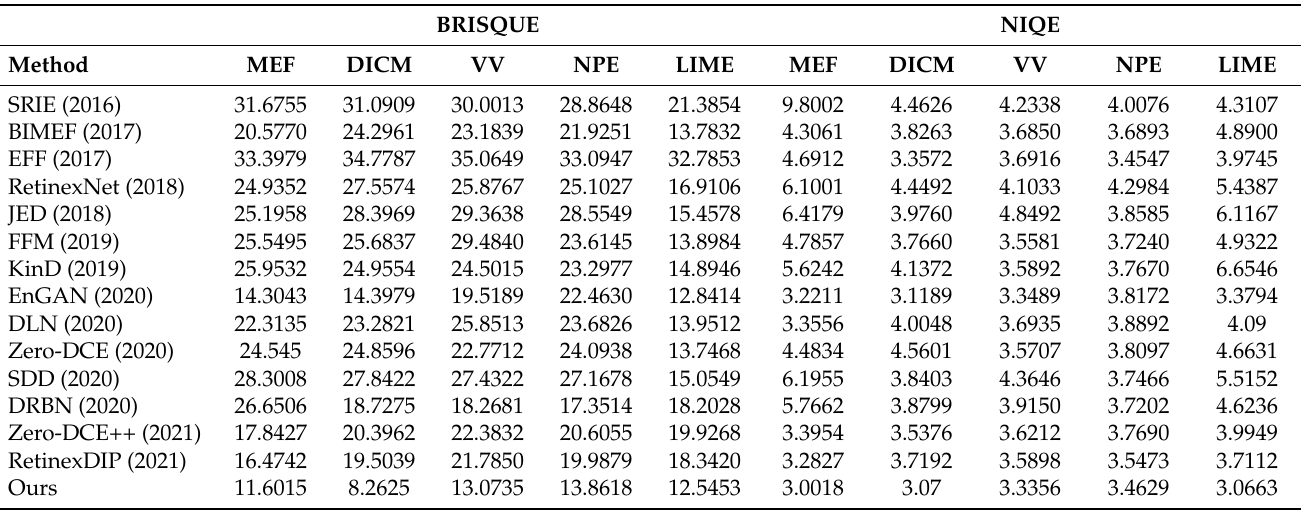
Table 6. Objective evaluation results of nonreference indicators BRISQUE and NIQE for the public